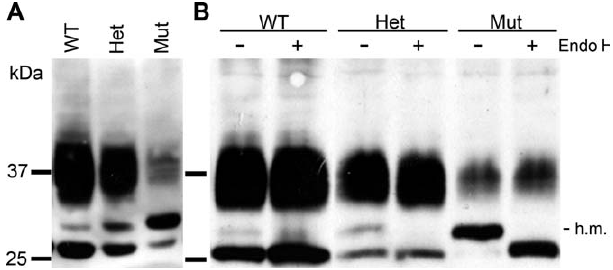
Figure 3. Immunoblot Analyses of AQP2 from Mouse Kidneys (A) Western blot analyses of total kidney membranes from littermate mice. An intermediate form of AQP2 at 31 kDa was identified in kidney membranes from a mutant mouse (Mut) and partially in a heterozygous mouse (Het). (B) Total kidney membranes were subjected to endoglycosidase H treatment (Endo H) prior to Western blotting. High-mannose (h.m.) glycosylated proteins that have not exited the ER are sensitive to endoglycosidase H digestion. DOI: